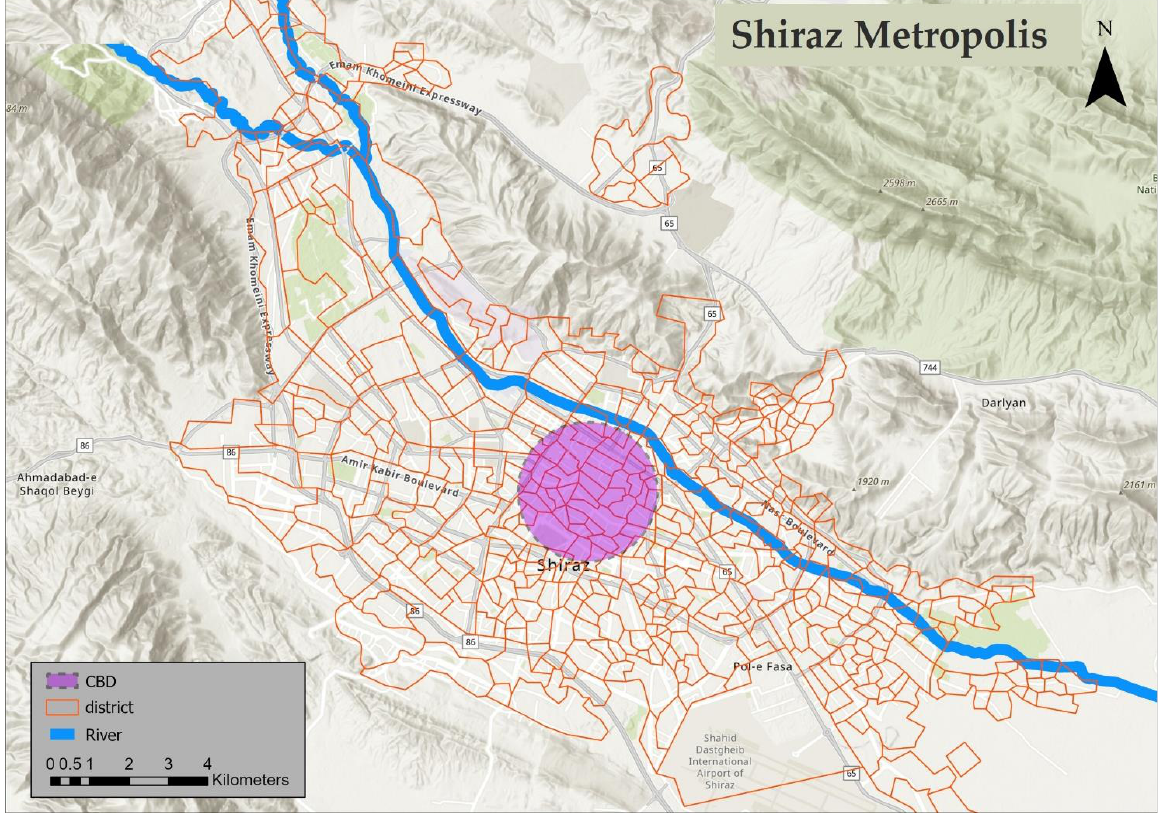
Figure 2. Case study area, Shiraz